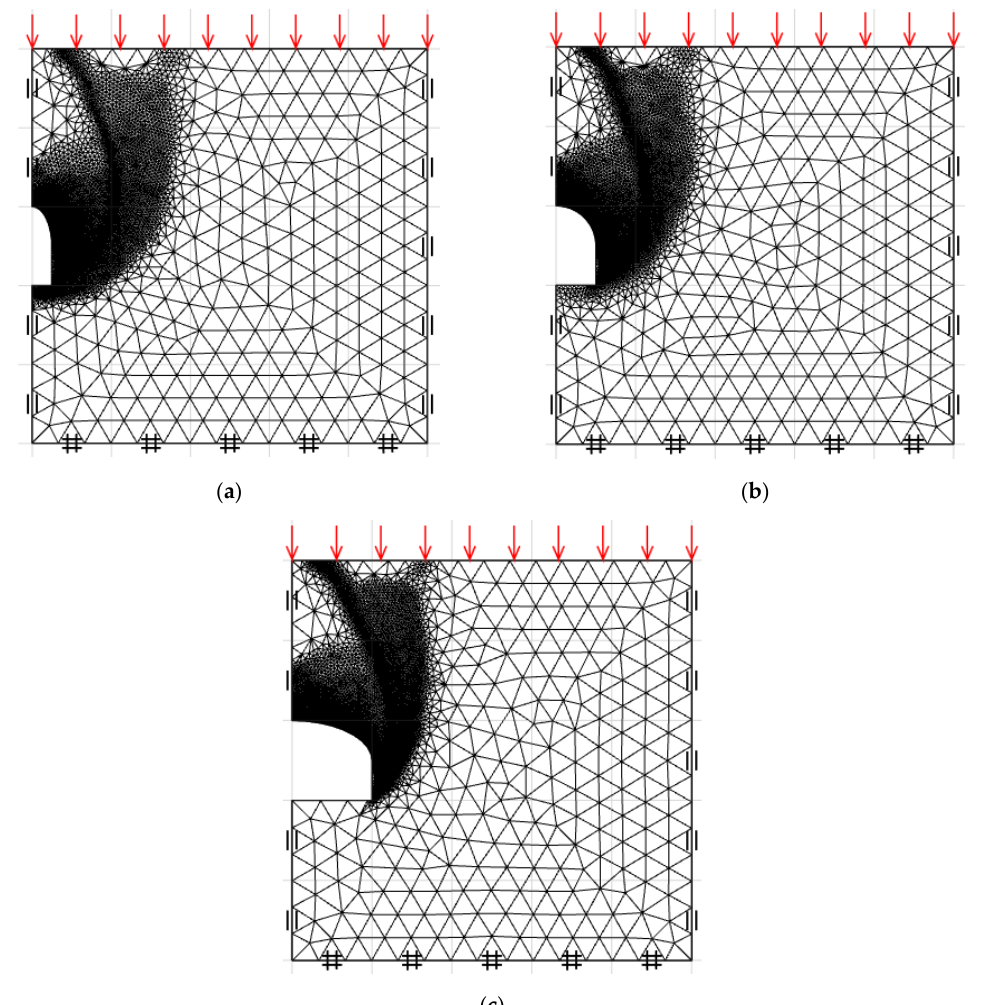
Figure 9. Final adaptive meshes of horseshoe tunnel: ( a ) B / D = 0.5, ( b ) B / D = 1 and ( c ) B / D = 2 ( GSI = 80, C / D = 2, σ ci / γ D = 1000, and m i = 20).